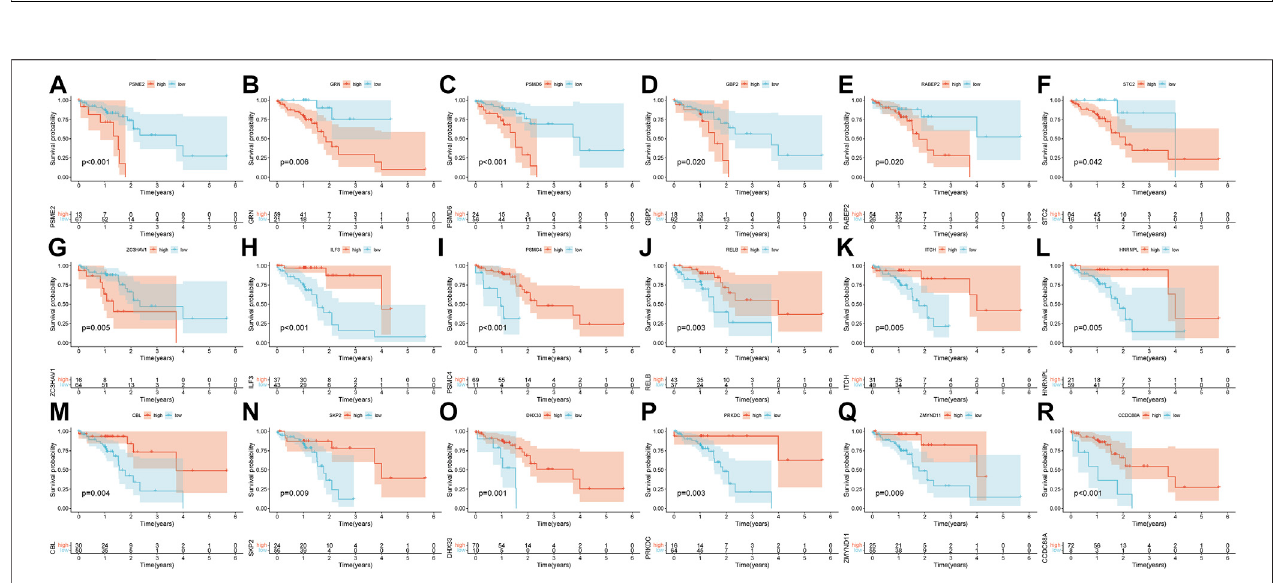
FIGURE 3 | Identi fi cation of the independent prognostic genes by WGCNA. (A) Analysis of the scale-free index and mean connectivity for various soft-threshold powers. (B) Dendrogramofalldifferentgenesclusteredbasedonthemeasurementofdissimilarity. (C) Theheatmapoftherelationshipbetweenmoduleeigengenesand tissue types. (D) Forest plot of the relationship between gene expression and the risk of survival time.